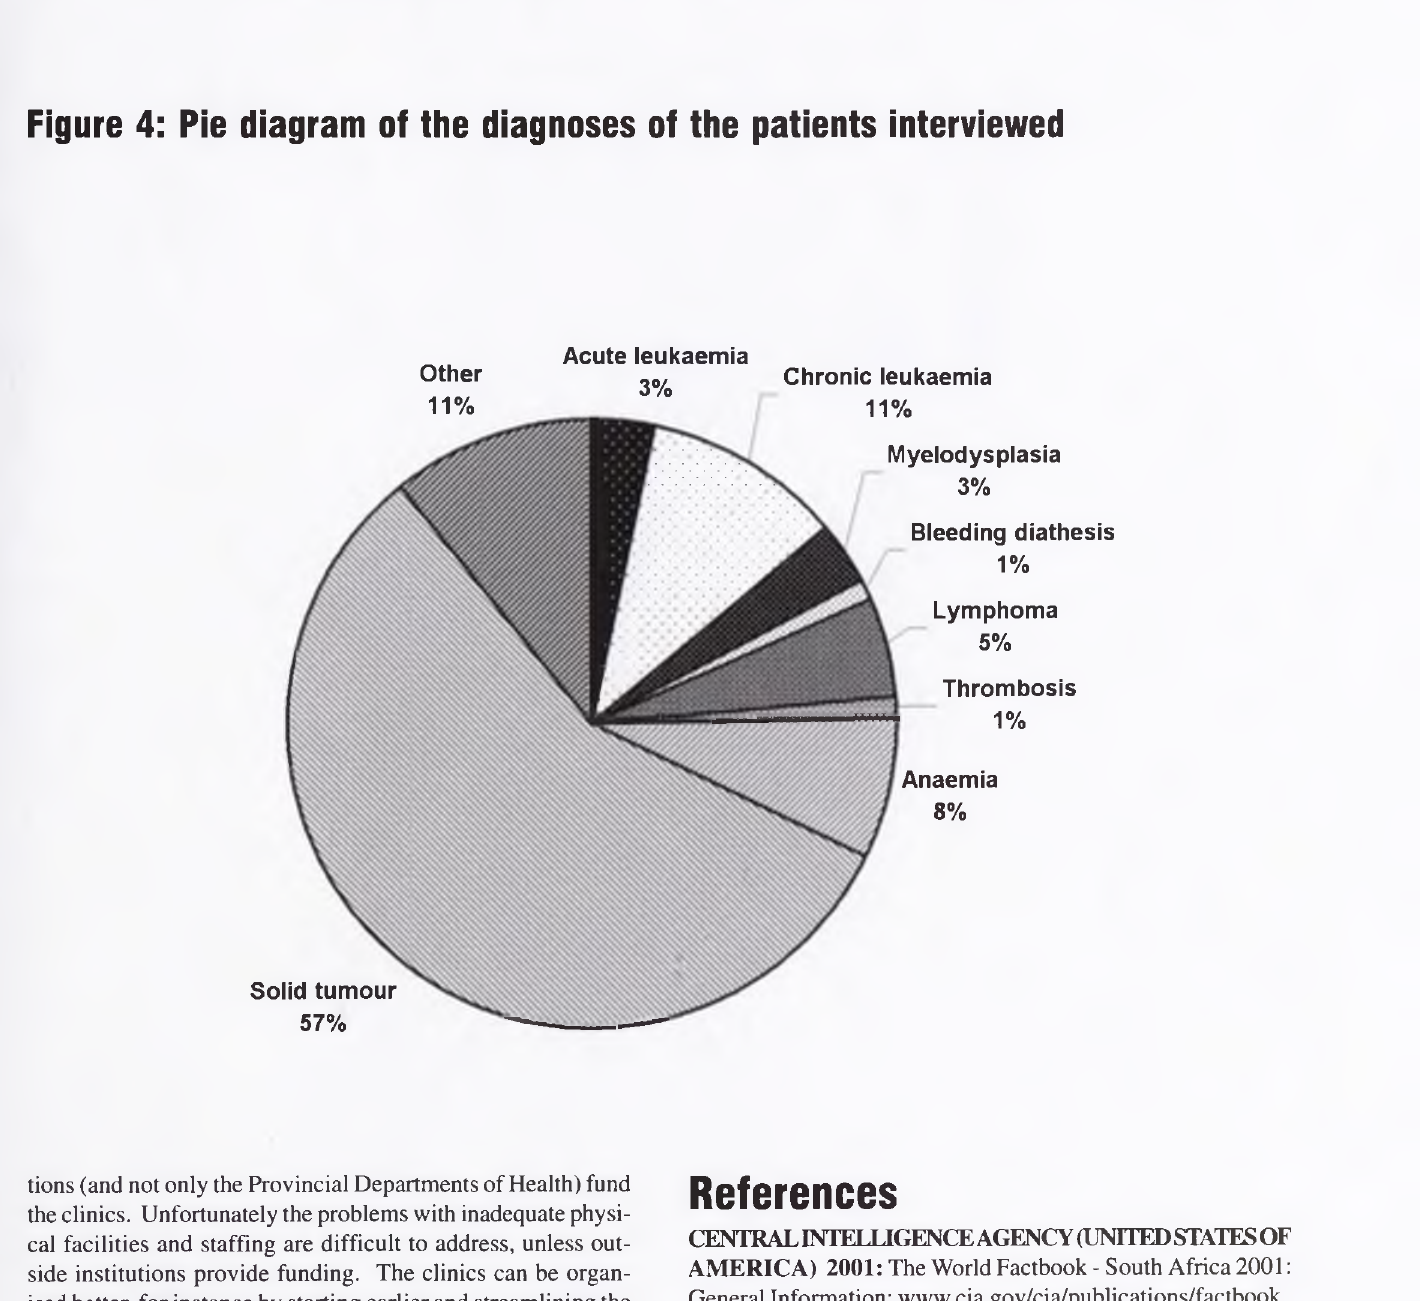
Figure 4: Pie diagram of the diagnoses of the patients interviewed